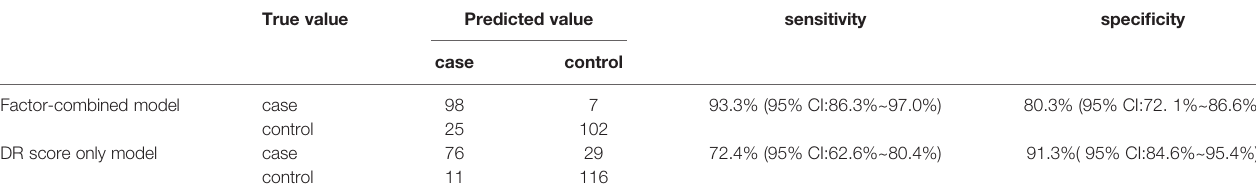
TABLE 5 | The classi fi cation results of all diabetes subjects for screening